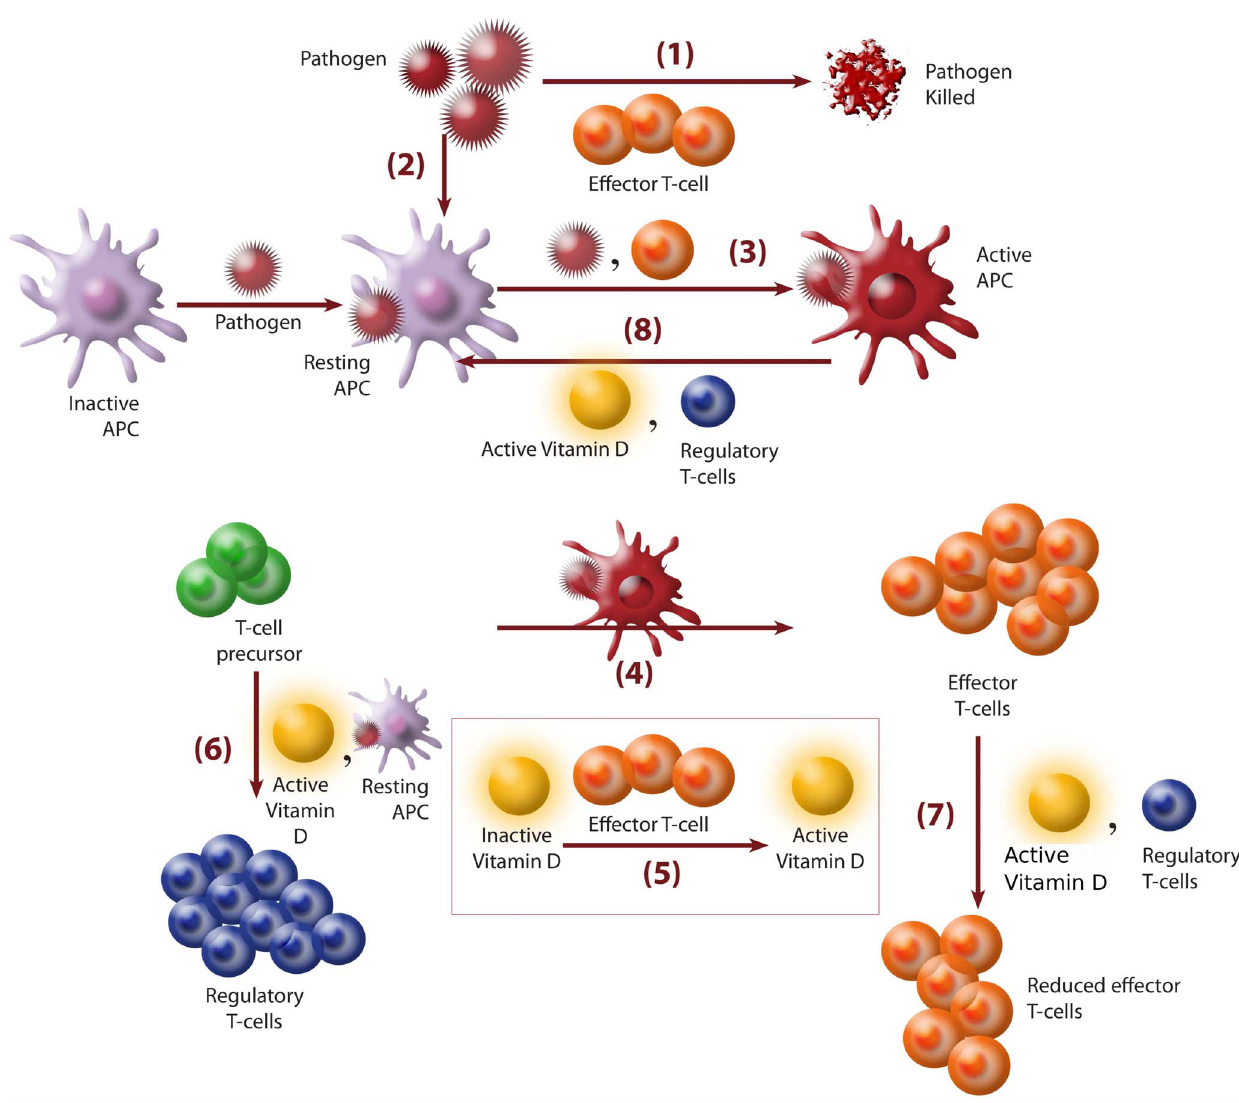
Figure 1. A schematic representation of adaptive immune responses in terms of cellular interactions including vitamin-D, based on some experimental results and clinical observations. In the scheme, the primary events are the following: (1) The main step is the annihilation of pathogen by effector T-cells. (2) In presence of pathogen, inactive APC becomes stimulated after pathogen recognition and form resting APC. (3) Resting APC is activated either by pathogen or by the presence of any effector T-cell [19,20]. (4) Activation of effector T-cells are initiated by these active APC. (5) Effector T-cells initiates the formation of active vitamin-D from its inactive form [24]. (6) Resting APC and active vitamin-D both can stimulate the production of regulatory T-cell from its precursor [25]. (7) Enhancement in the rate of production of effector T-cells is controlled by both regulatory T-cells (T Reg ) and active vitamin-D [24]. (8) In addition, vitamin-D and regulatory T-cell up-regulate the formation of more resting APC from active APC